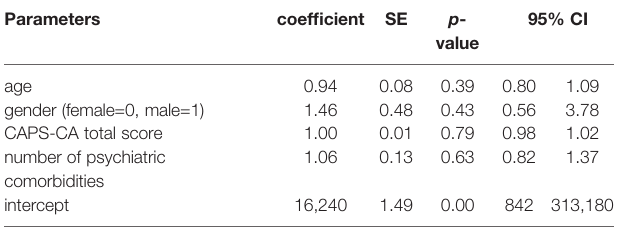
TABLE 3 | Determinants of costs (n=87).